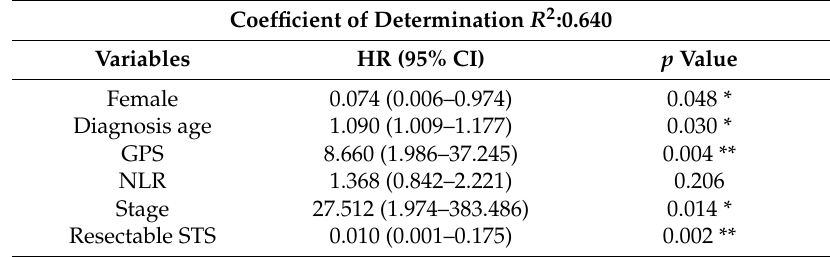
Table 3. Binomial logistic regression analysis for the risk factor of death within one year. Coefficient of Determination R 2